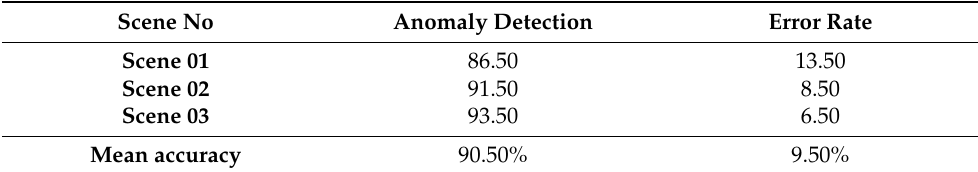
Table 6. Confusion matrix of proposed EPB method over A Day on Campus (ADOC) data set.